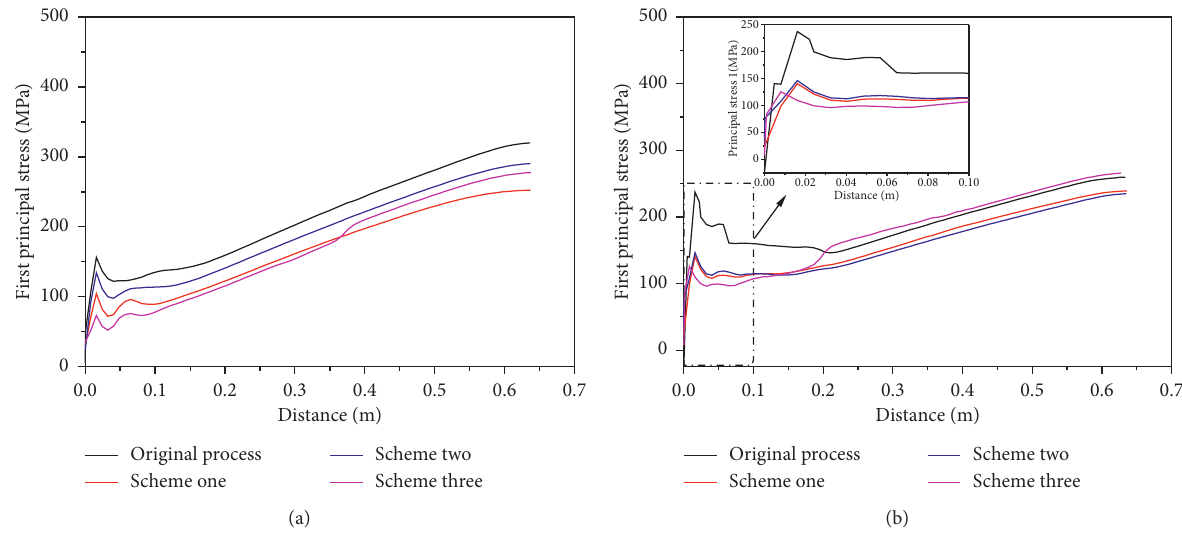
Figure 15: Comparison of the first principal stress at 4mm below the wide surface under different water distribution schemes. (a) Outlet of zone 2. (b) Outlet of zone